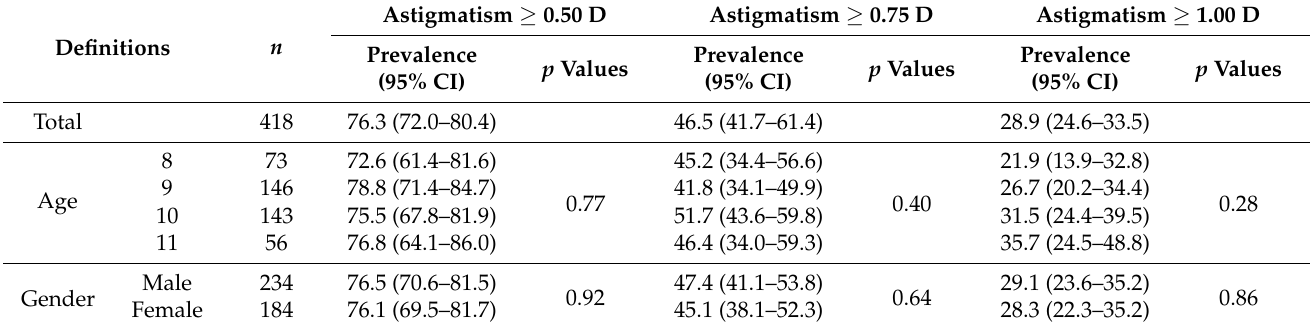
Table 1. Comparisons of prevalence of different definitions of astigmatism across age and gender.